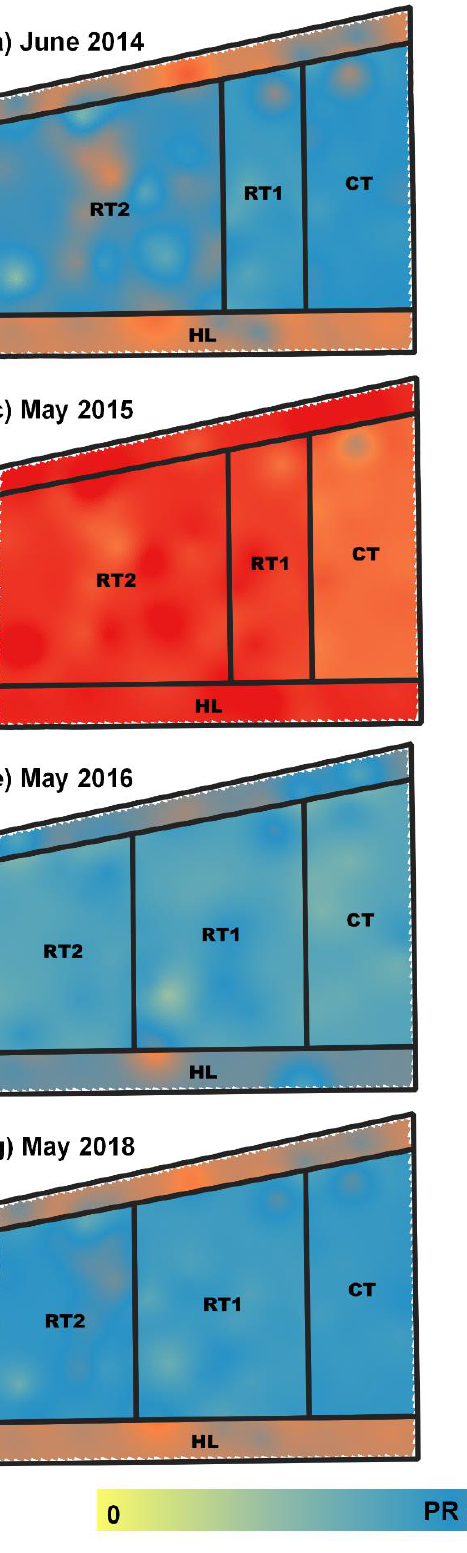
Figure 6. Predicted penetration resistance (PR) in the depth of 36–45 cm using Multiple Linear Regression (MLR). Conventional tilled plot (CT), both reduced tilled plots affected by one-time inversion tillage (RT1: chisel plough; RT2: disc harrow) and the headlands (HL).